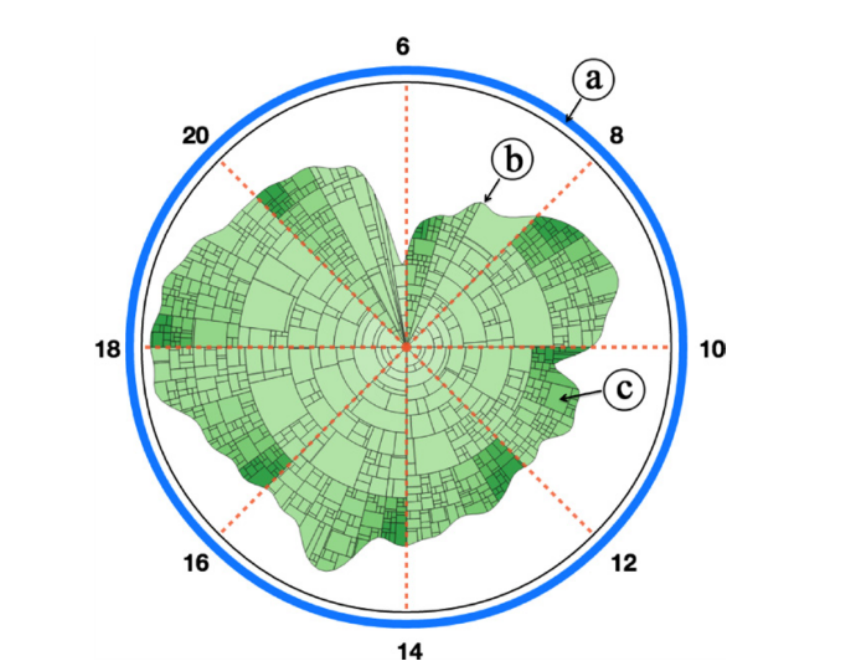
Figure 23. The contour-based treemap view: ( a ) the circular segmentation of time throughout the day; ( b ) the temporal contour of visits to a given location.; and ( c ) each sector represents a home location of the visitors during the time frame. Image courtesy of Wu et al.